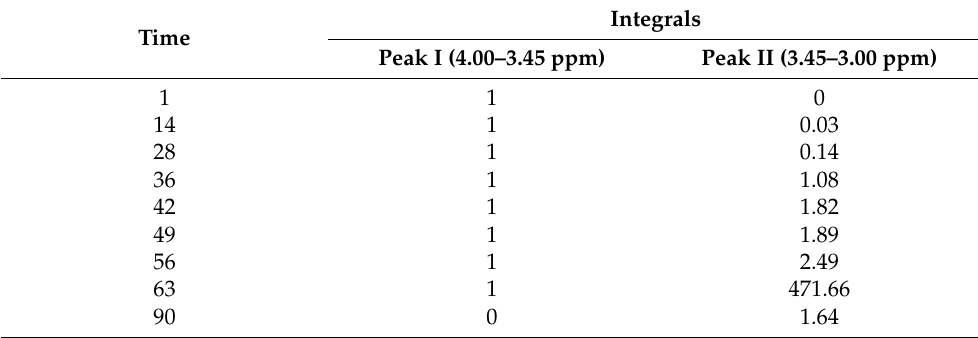
Table 2. The resonance integrals of peak I (4.00–3.45 ppm) and peak II (3.45–3.00 ppm). Time